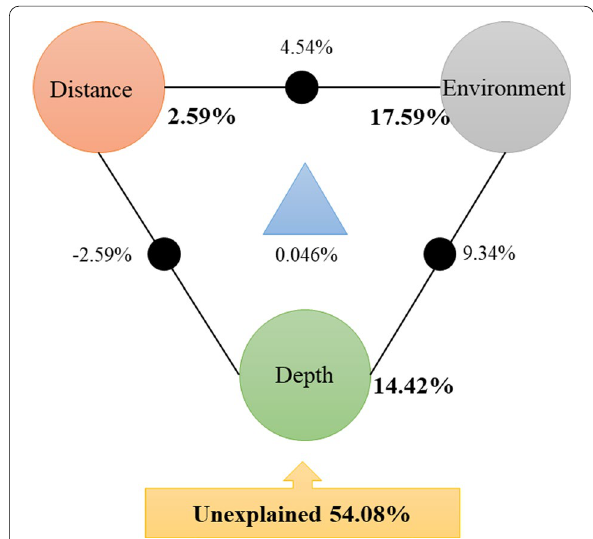
Fig. 7 Variation partitioning analysis showing the percentages of variance in bacterial communities explained by Distance (Latitude, Longitude), Environment (Temperature, Moisture, Salinity, TC, TN, TP, C/N, TOC, AN, AP, pH, Clay, Silt and Sand) and Depth. Each diagram represents the variation partitioned into the relative effects of each factor or a combination of